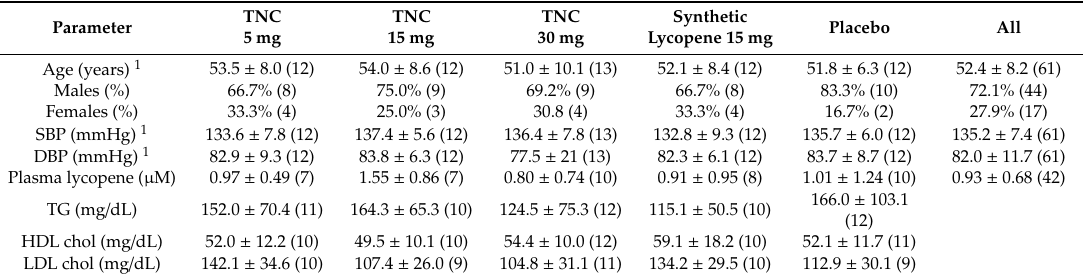
Table 1. Baseline characteristics of the study